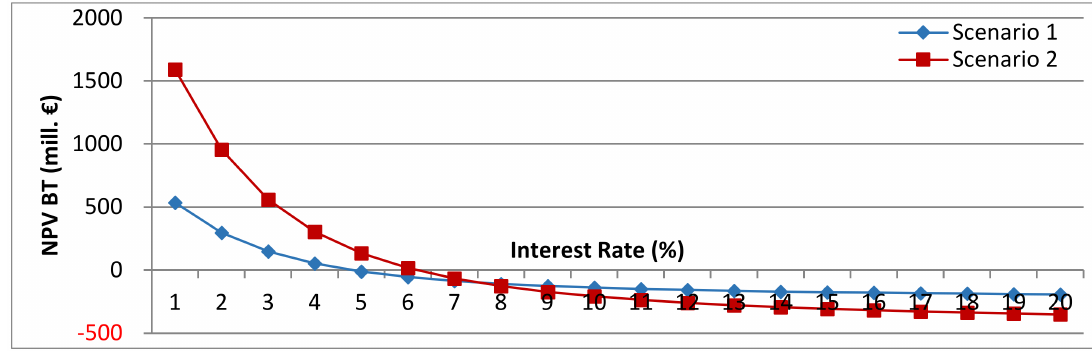
Figure 10. Net present value before tax as a function of the interest rate, Scen. 1 and 2, excl. flooding time.